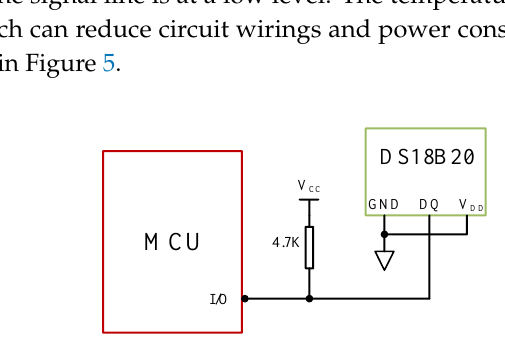
Figure 5. Diagram of DS18B20 parasitic power supply.